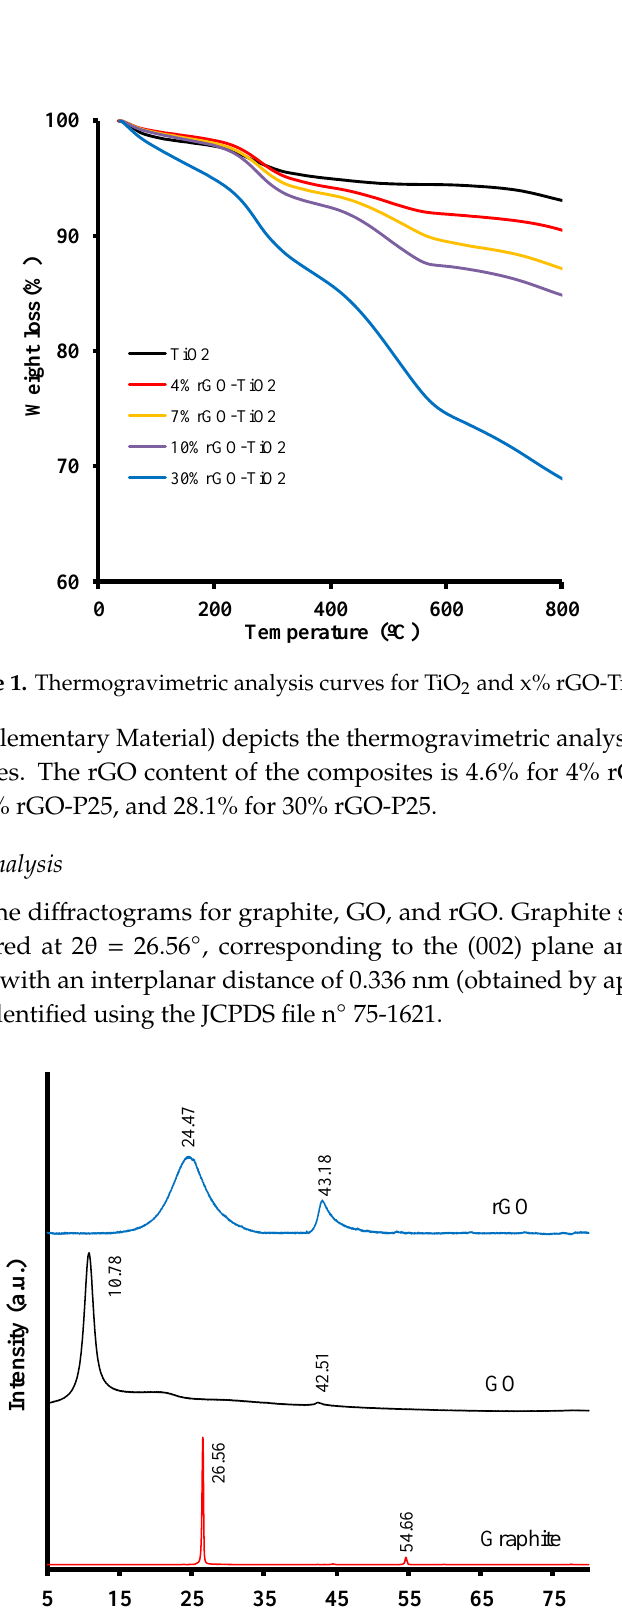
Figure 2. X-ray di ff ractogram for graphite, GO, and Figure 2. X-ray diffractogram for graphite, GO, and rGO. Figure 2. X-ray diffractogram for graphite, GO, and rGO.